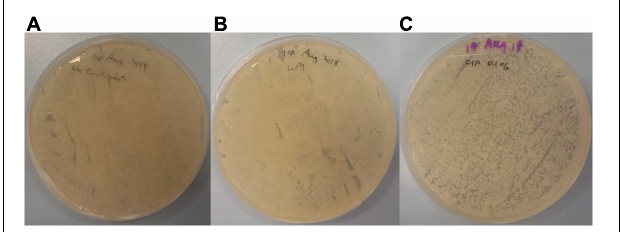
FIGURE 6 | TSA plate spread from swab samples obtained from cutting board surfaces that underwent no hygienic treatment (A) , wet market traditional scraping (B) , and 0.1% sodium hypochlorite treatment (C)